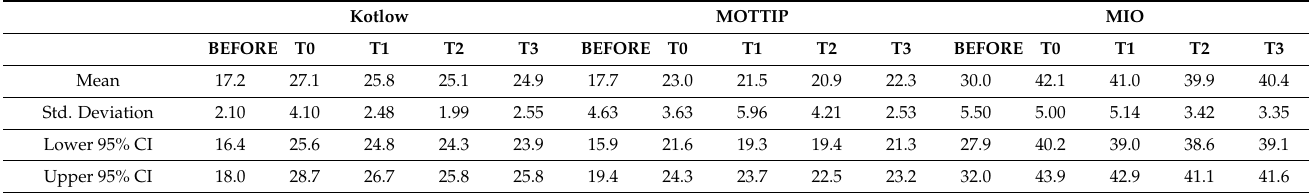
Table 1. Descriptive statistic according to Kotlow’s free-tongue measurement, MOTTIP and MIO.